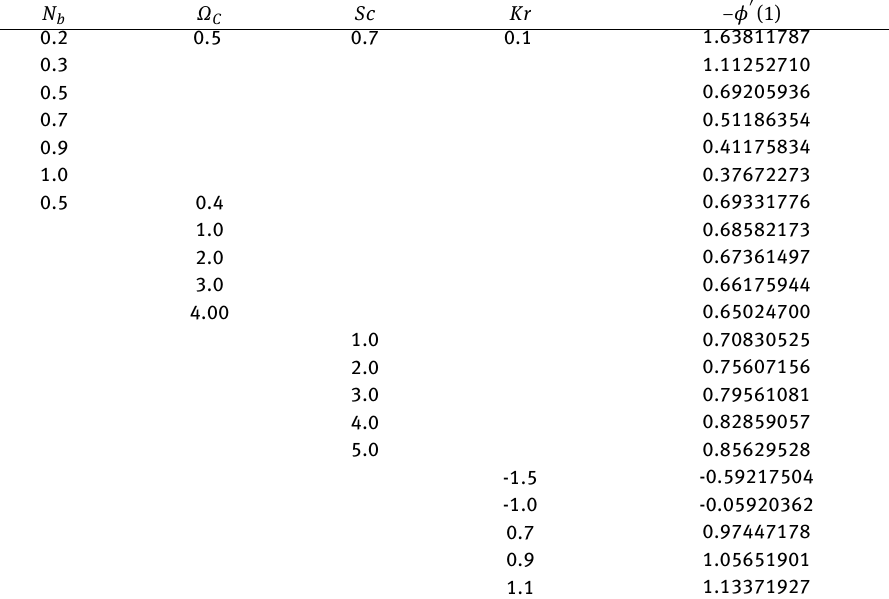
Table 6: Numerical values of mass transfer rate for various values of N b , Ω C , Sc , Kr with fixed Ω T = 0.4, β = 0.5, S = Ha = 0.5, N t = 0.1, Ec = 0.5, Pr =